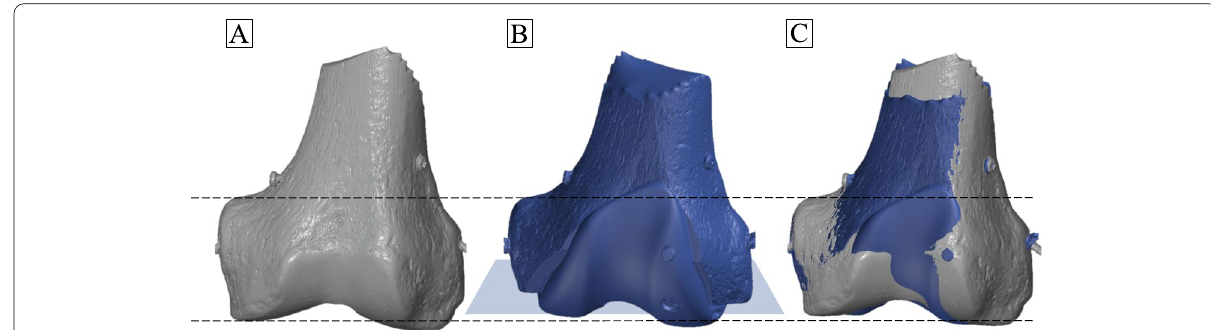
Fig. 3 3D‑scan based evaluation of the distal femur pre‑ and postoperative. Preoperative ( a ) and postoperative ( b ) 3D‑scan of the distal femur and overlay of both scans ( c ). Blue square ( b ) illustrates the plane of the distal femoral